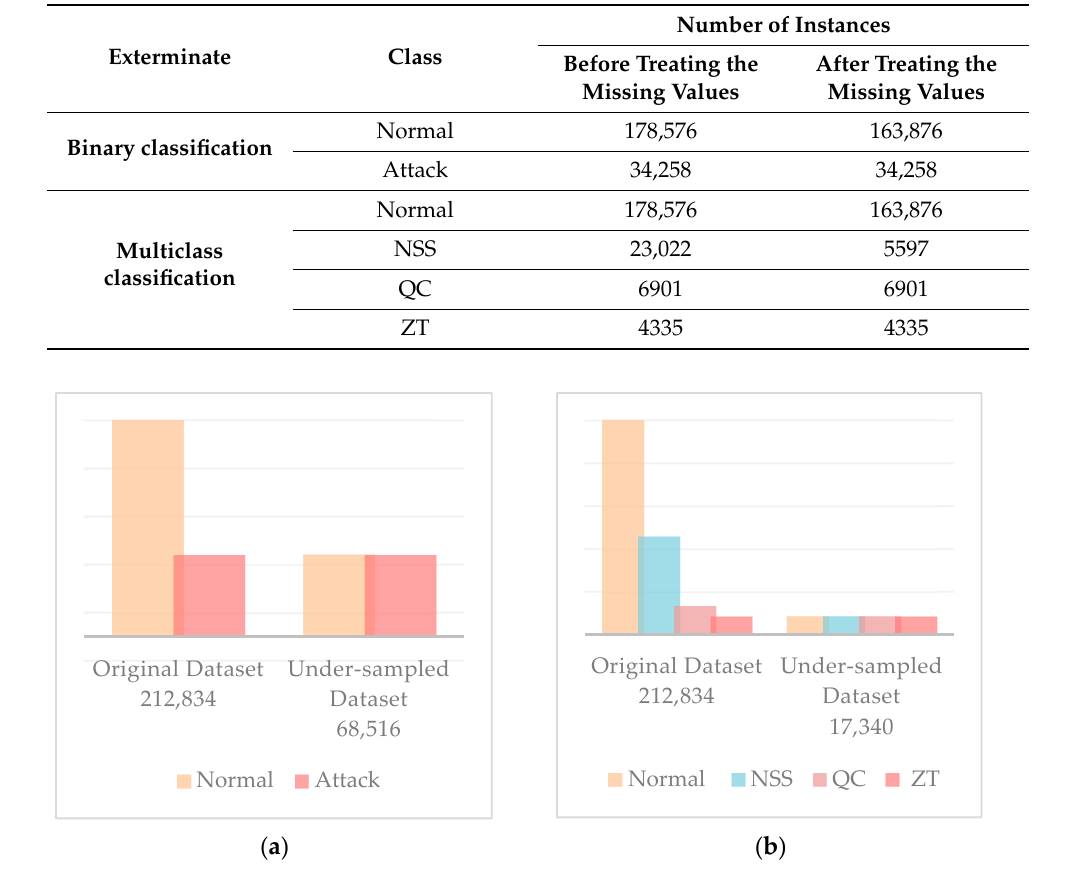
Figure 2. Randomized under-sampling of the dataset for ( a ) binary classification and ( b ) multiclass classification.